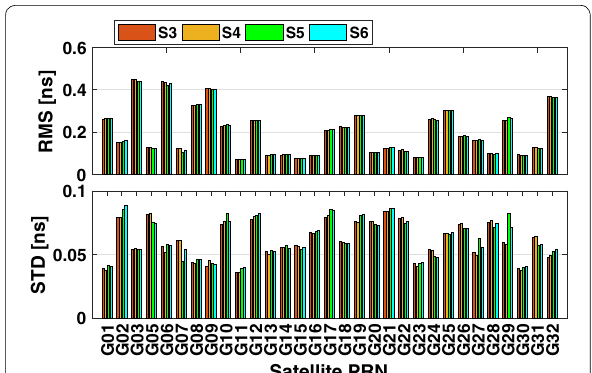
Fig. 7 GPS average clock accuracy of per satellite